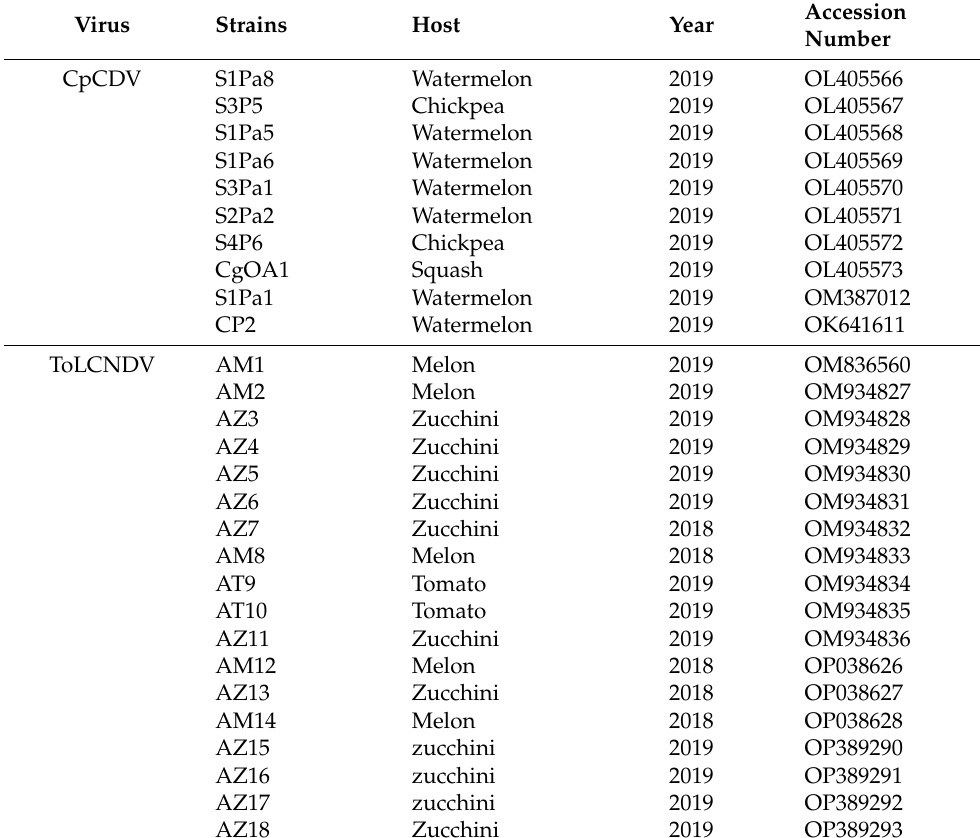
Table 2. Sequenced CpCDV and ToLCNDV isolates reported in the present study. Virus Strains Host Year CpCDV